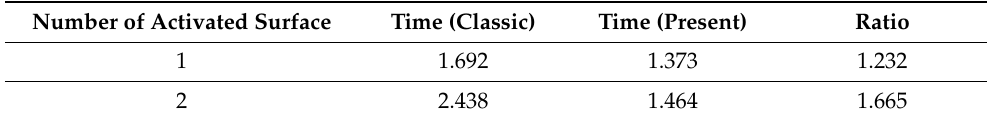
Table 2. Comparison of time